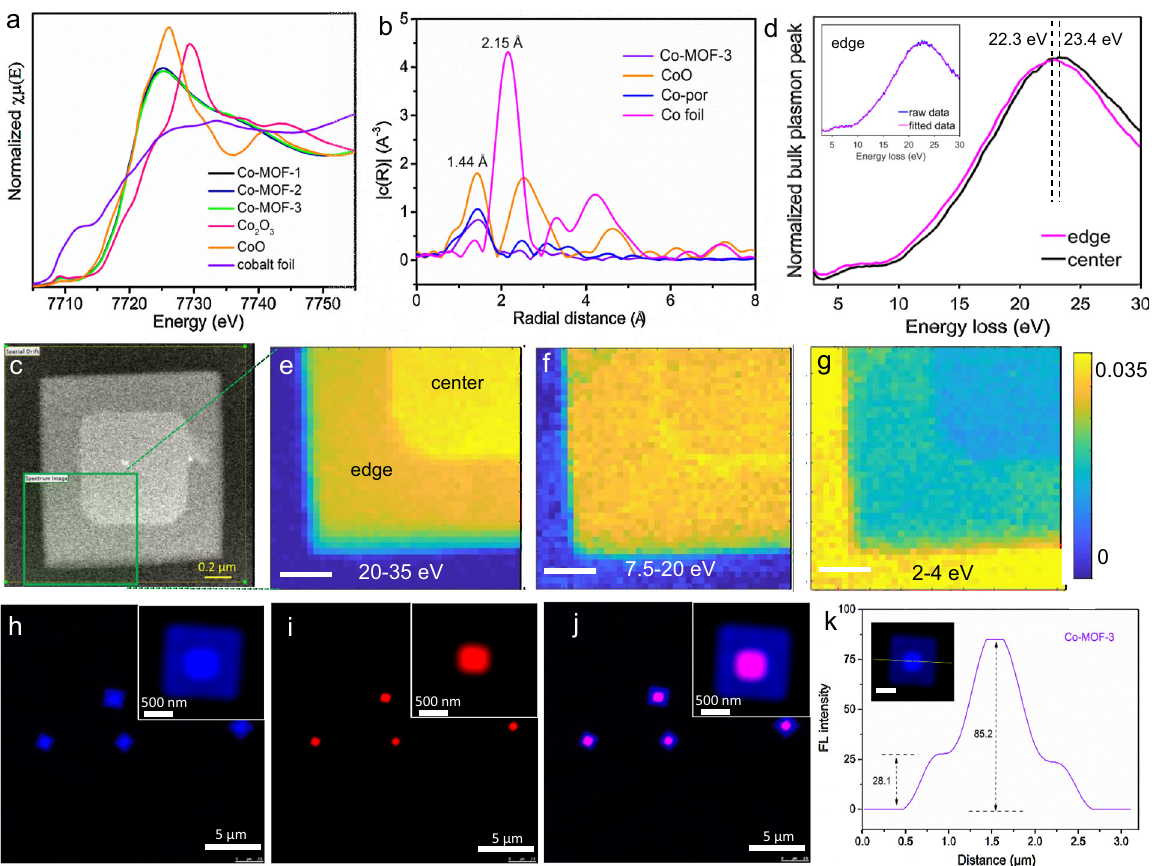
Fig. 3 Elemental analysis of Co-MOF-3 nanostacks. a Normalized XANES spectra at Co K -edge for all the Co-MOFs and references of Co 2 O 3 , CoO, and Co foil. b Co K -edge Fourier transform k 2 -weighted EXAFS (not phase corrected) of Co-MOF-3, CoO, Co foil, and Co-porphyrin (Co-por). c HADDF image of of Co-MOF-3. d The low-loss EELS spectra of edge and center (after Gaussian smoothing). The inset is the raw data and Guassian fi tting curve of EELS spectrum of edge. Low-loss EELS mapping in the range of e 20 – 35 eV, f 7.5 – 20 eV and g 2 – 4 eV. The low-loss EELS mapping was normalized by the integral signal, extracted with background removal, and smoothed by the Gaussian fi tting model. Non-negative matrix factorization (NMF) was applied to the 41 × 41 pixels low-loss EELS spectra dataset. h – j Super-resolution multiphoton confocal images of Co-MOF-3. The excitation of wavelength is 405 nm and the emission was collected using ( h ) a 412 – 472-nm bandpass fi lter (blue) or ( i ) a 559 – 682-nm bandpass fi lter (red), respectively, and j merged image of h and i . k The FL intensity pro fi le of the inset Co-MOF-3 image; the scale bar is 500